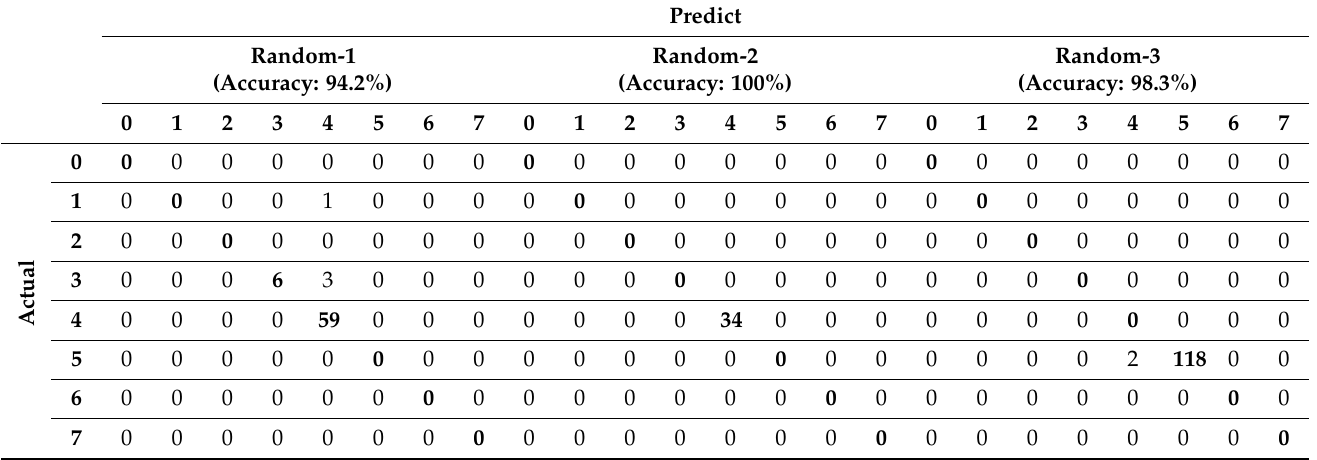
Table 9. Confusion matrix for Room 3 Sequence 6 (with median filter).